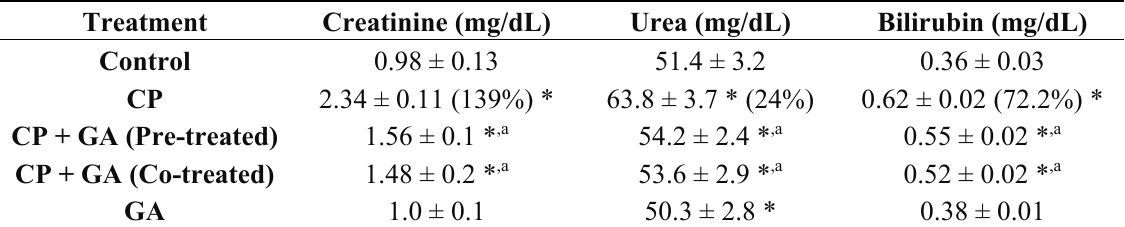
Table 1. Protective effects of gallic acid on cyclophosphamide induced changes in the levels of plasma creatinine, urea and bilirubin in rats.